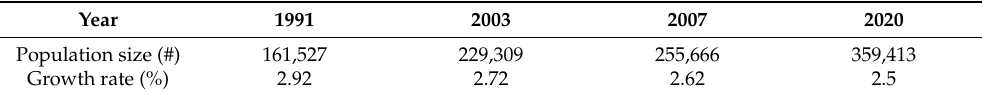
Table 11. The population size of Matenchose watershed between 1991 and 2020.